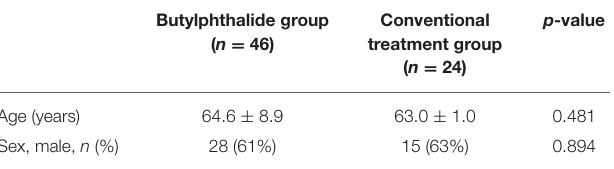
TABLE 1 | Characteristics of the participants. TABLE 2 | Changes in matrix metalloproteinase-9 (MMP-9) after admission according to the treatment